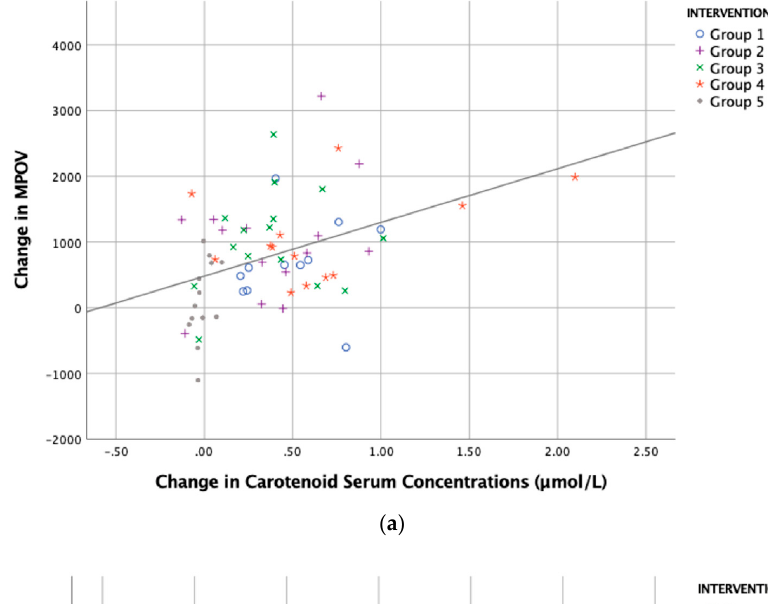
Figure 4. Effect of different formulations in change of serum concentrations. Between-group differences in change in ( a ) Z and ( b ) MZ serum concentrations expressed as change from baseline and 6 months. Z and MZ serum response in Group 4 was significantly higher compared to the other active interventions and placebo ( p < 0.000 to p = 0.019). Outliers are marked with a circle (O) and extreme outliers are marked with an asterisk (*) on the boxplot